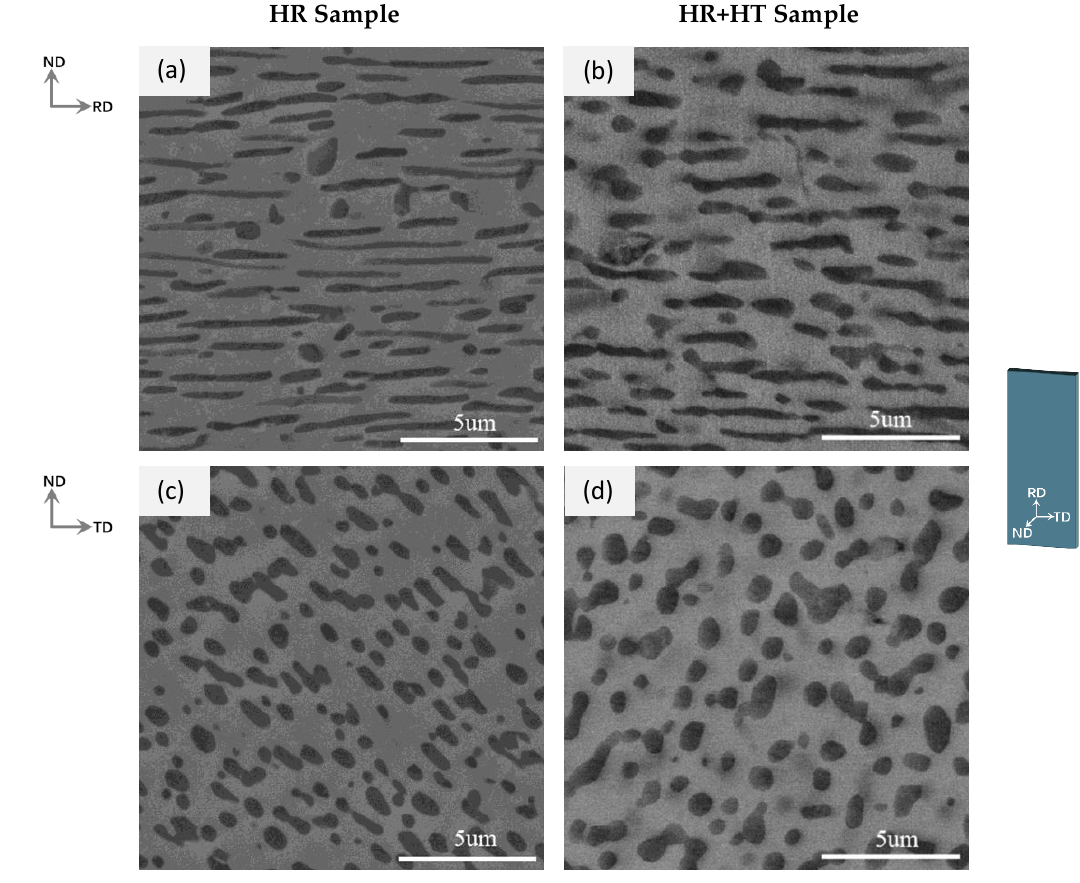
Figure 3. Microstructures in the RD-ND and TD-ND planes of HR and HR+ HT samples. ( a , b ): ND-RD plane; ( c , d ): ND-TD plane.